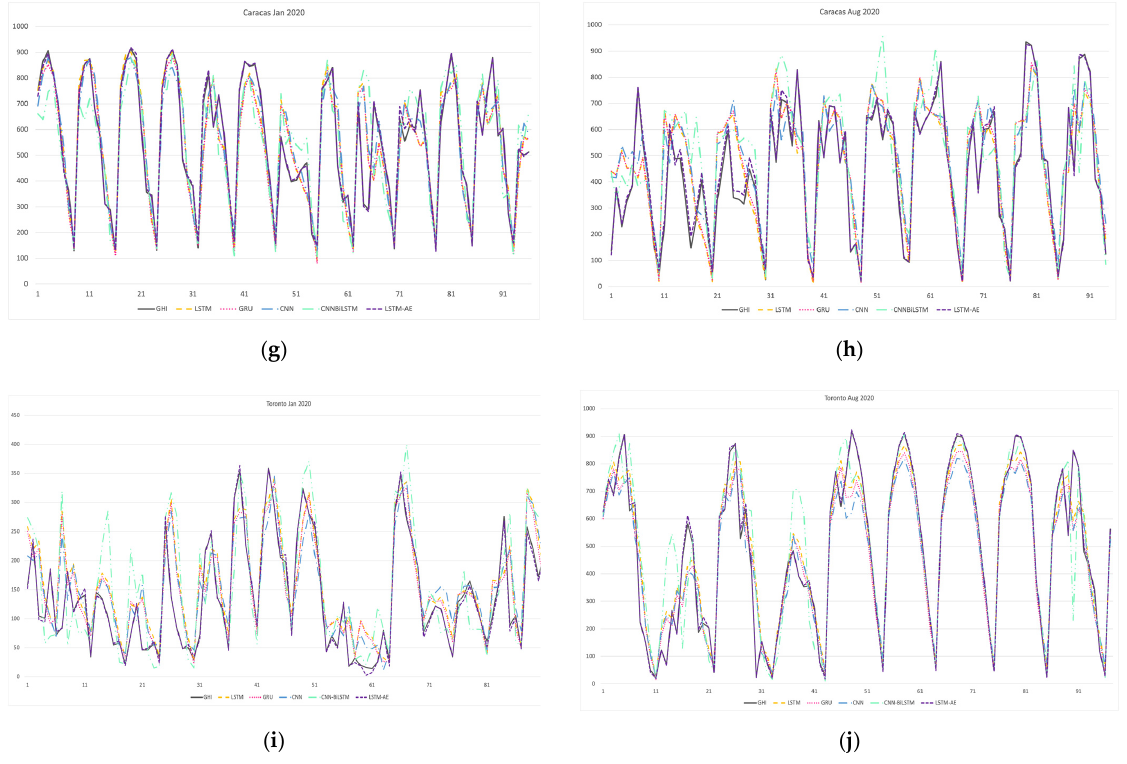
Figure 28. Summer vs. winter—actual vs. predicted GHI of 5 models for: ( a ) Al-Jouf Jan; ( b ) Al-Jouf Aug; ( c ) Al-Khafji Jan; ( d ) Al-Khafji Aug; ( e ) Wadi-Addwasir Jan; ( f ) Wadi-Addwasir Aug; ( g ) Caracas Jan; ( h ) Caracas Aug; ( i ) Toronto Jan; ( j ) Toronto Aug .